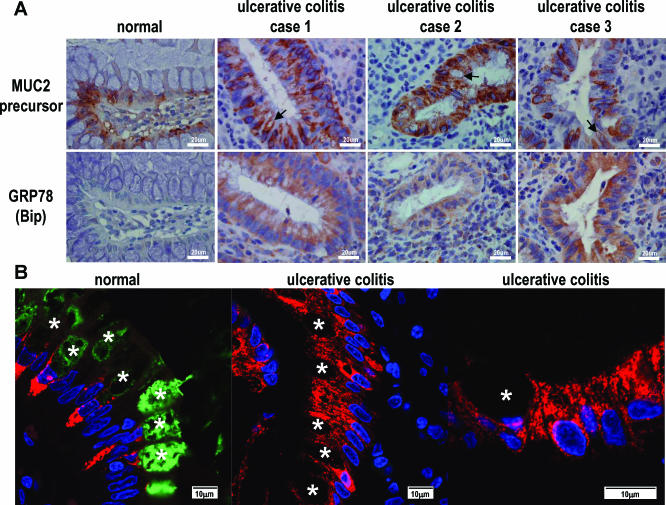
Evidence for MUC2 Precursor Accumulation and ER Stress in Human UC(A) The MUC2 precursor and GRP78 were detected immunohistochemically. One normal colonic biopsy and three representative cases of UC of ten examined are shown. Note the MUC2 precursor antibody does not react with goblet cell thecae, where present (arrows).(B) Confocal microscopy of goblet cells from the colon of an unaffected individual and two UC patients showing accumulation of the MUC2 precursor identified with antibody 4F1 (red) throughout the cytoplasm in UC goblet cells, many of which lack thecae, but not in normal colon. Note that 4F1 does not react with goblet cell thecae (identified by *) in normal or UC colon, demonstrating it cannot react with O-glycosylated MUC2 that has exited the Golgi apparatus. Note that some goblet cell thecae contain MUC2 with O-linked sugars identified with the DBA lectin (green) but that UC goblet cells are mostly DBA lectin-negative. Nuclei are stained with DAPI (blue). Single colour images of these composites are provided in Figure S7.Scale bars = 20 μm (A) and 10 μm (B).